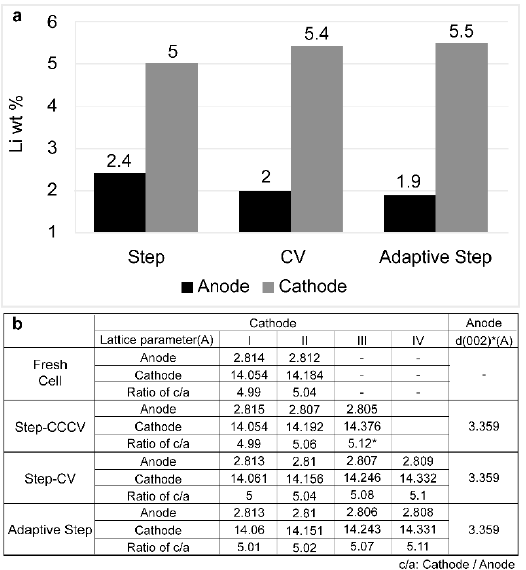
Figure 11. Analysis of the electrode bulk characteristics: ( a ) the inductively coupled plasma mass spectrometry results, and ( b ) the x-ray diffraction results.